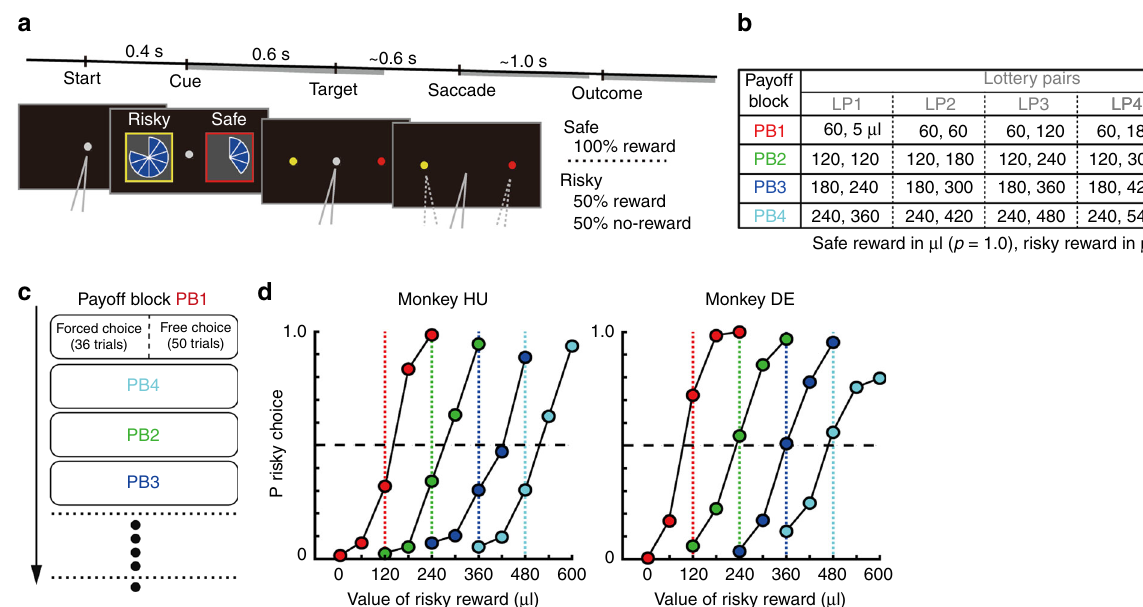
Fig. 1 Lottery task and choice behavior. a A sequence of events in free choice trials. Pie charts indicated reward magnitudes from 60 to 600 μ l in 60 μ l increments. Gray color of the central fi xation target indicated that the monkeys could choose either option freely. In the forced choice trials (red or yellow fi xation color), monkeys were required to choose the color-matched target among the alternatives, unless otherwise the trials were aborted. Positions of the risky and safe options were fi xed during a single payoff block. Gray bars (top) indicate the 1.0 s time periods used to analyze neuronal activity; cue, saccade and feedback periods. b Payoff matrix: in each payoff block 1 to 4, the monkeys chose between a 100% fi xed amount of water reward and a lottery that would deliver a reward with 50% probability (5 different risky reward magnitudes per one block). For example, in payoff block 1 (PB1), the safe 60 μ l reward was represented by a 1/10 fi lled pie chart and the risky option was represented by a pie chart ranging from empty to 4/10 full. c An example payoff block sequence (randomly selected without replacement until all four payoffs were presented). In a block the fi rst 36 trials were forced choice trials. Then, 50 free choice trials (10 of each type) followed in random order. d Percentages (P) of risky choice plotted against magnitude of risky reward in each PB (indicated by color). Dashed colored lines indicate where risky and safe options have equal expected